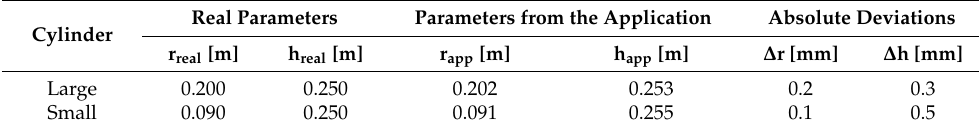
Table 2. Comparison of the real parameters and parameters from the application.